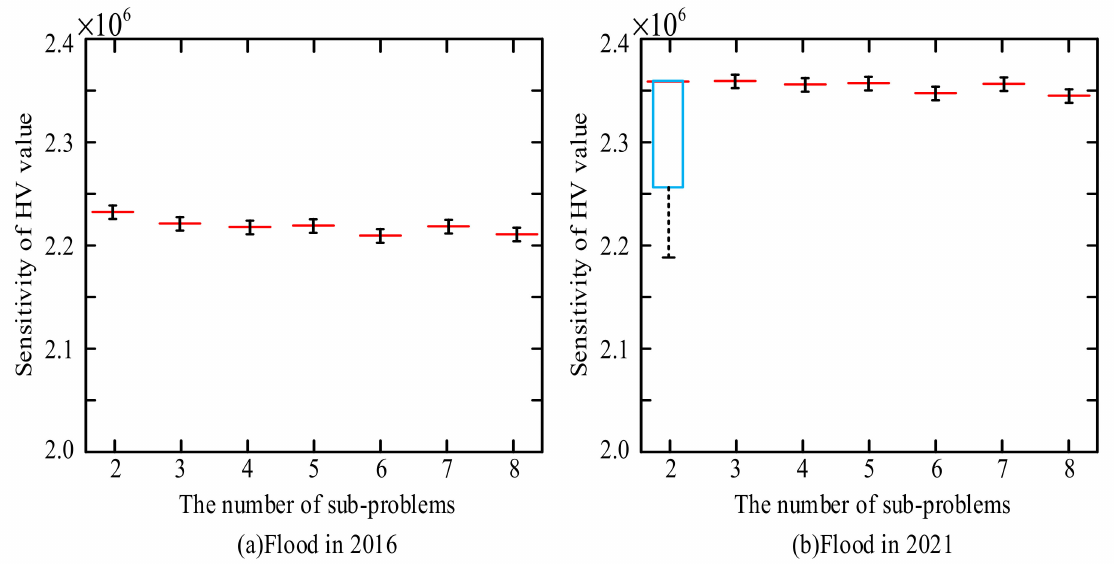
Figure 8. Parameter sensitivity analysis of different subproblems in two floods in 2016 and